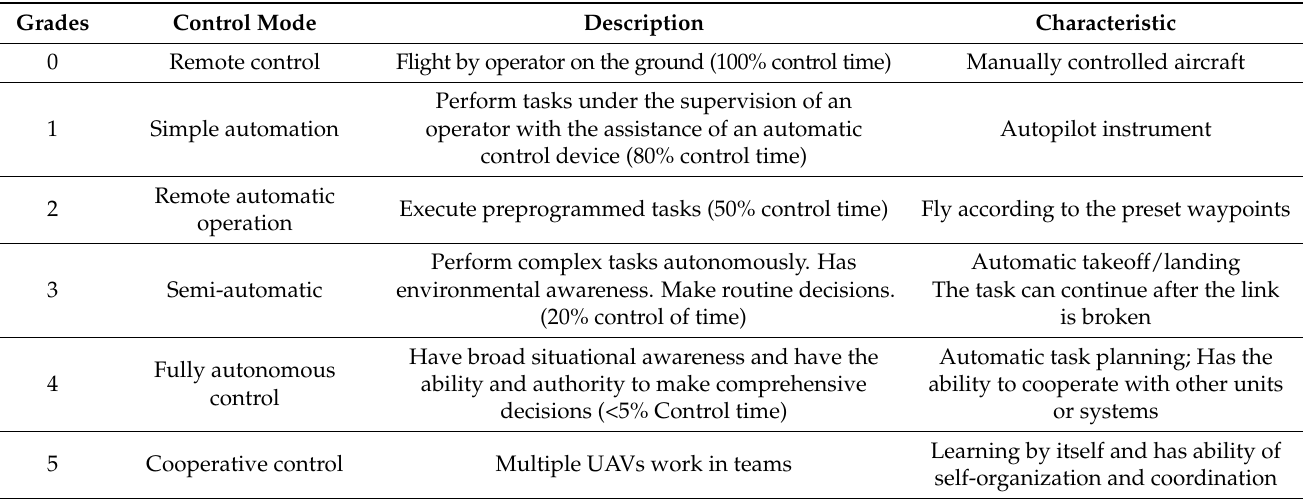
Table 1. Defined autonomy level of the aircraft system by